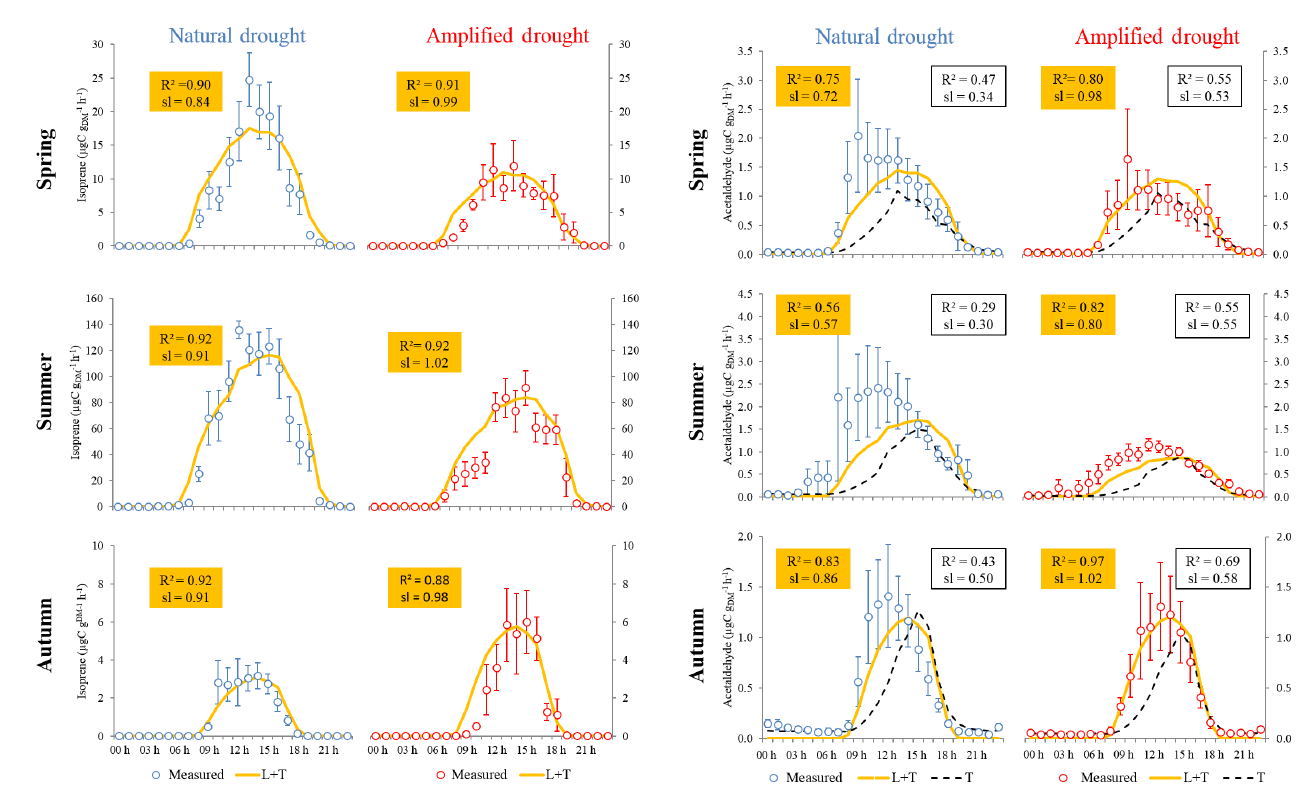
Figure 4. Diurnal pattern of acetaldehyde emission rates, where points represent measured emission, the yellow line corresponds to modeled emission rates according to the L + T algorithm (ER L + T ) and the dotted line corresponds to modeled emission rates according to the T algorithm (ER T ) . R 2 and slope (sl) of correlations between measured ( x axis) and modeled ( y axis) emissions are presented in the yellow frame for L + T and in the white frame for T . Correla- tions were obtained without forcing data to pass through the origin. Values are mean ± SE, n =